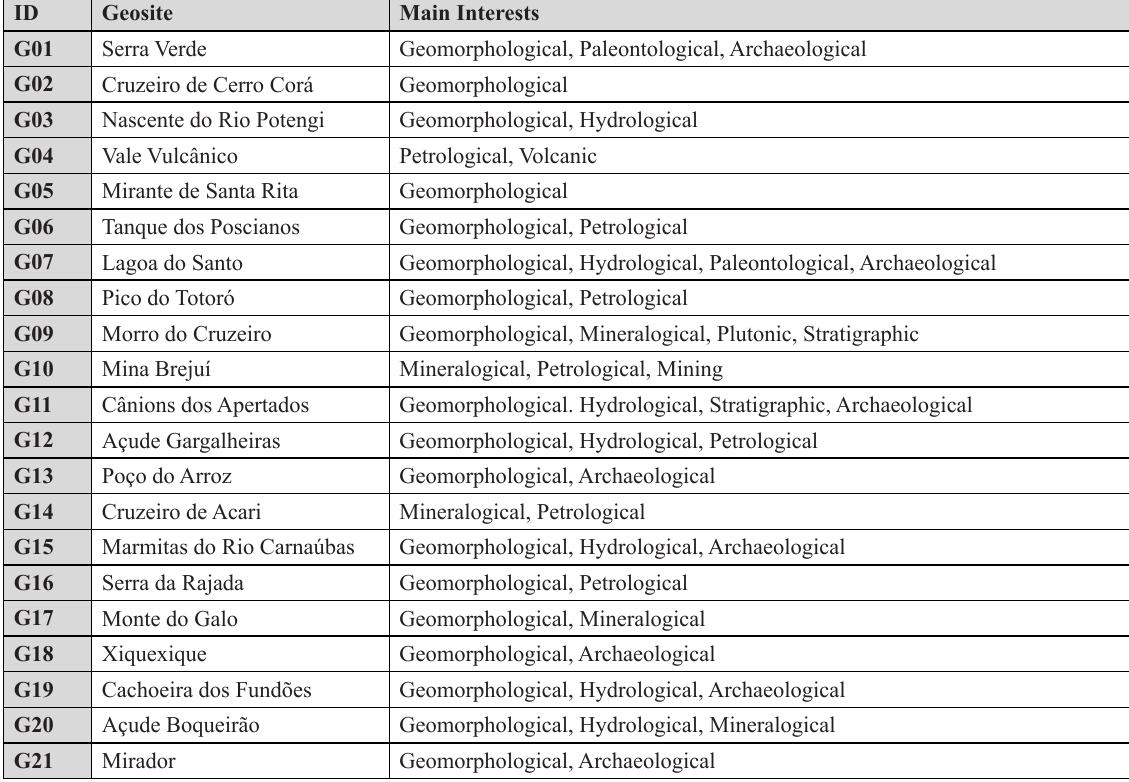
Table 2. List of Seridó Aspiring Geopark geosites and its main